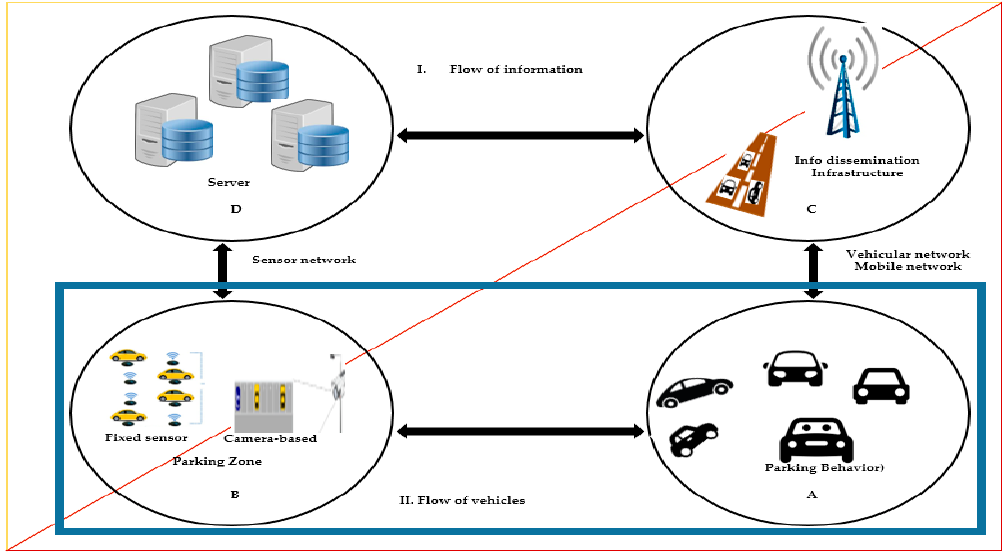
Figure 1. The ecosystem of the typical parking system which has two main sections, named flow of information (I) and flow of vehicles (II).